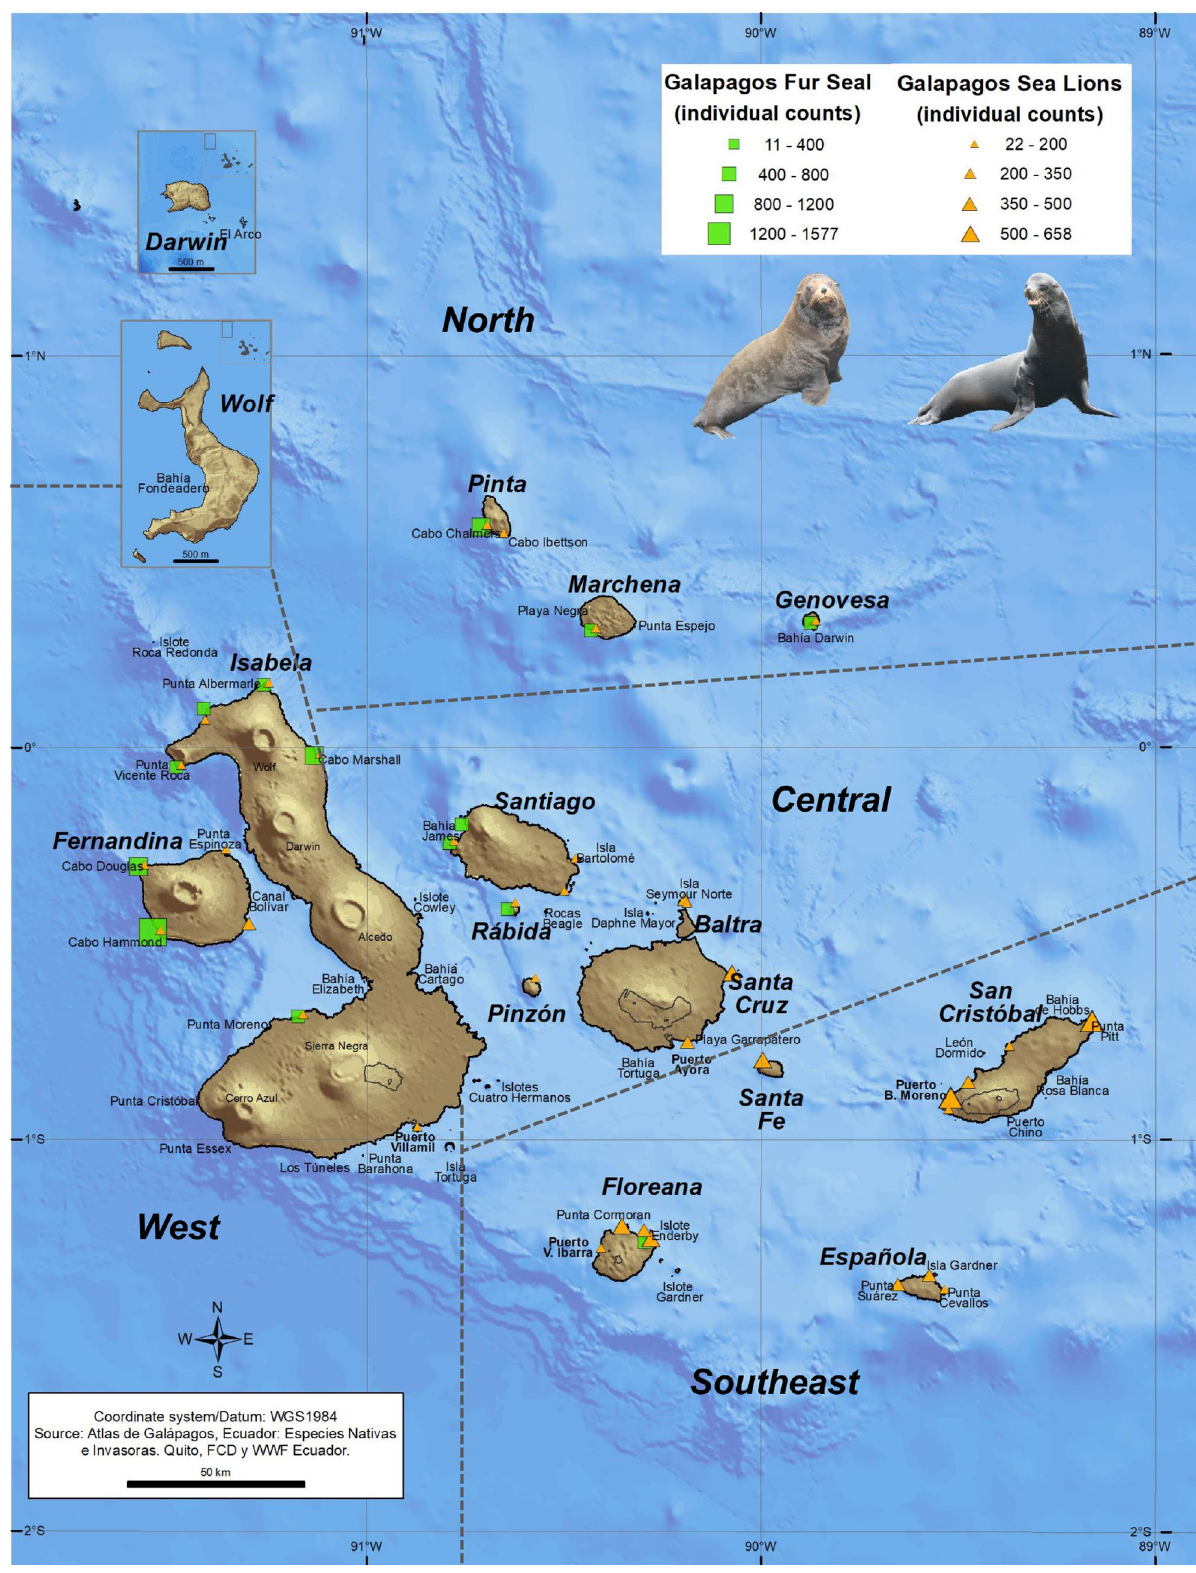
Figure 1. Breeding rookeries of the Galapagos sea lion (orange symbols) throughout the Galapagos Archipelago and Galapagos fur seal (green symbols) in western and northern islands of the archipelago. The symbol sizes are according to the individuals’ abundance. The regionalization scheme of the archipelago is shown. ( Map courtesy of Byron X. Delgado, GIS Research / Knowledge Management, Charles Darwin Foundation